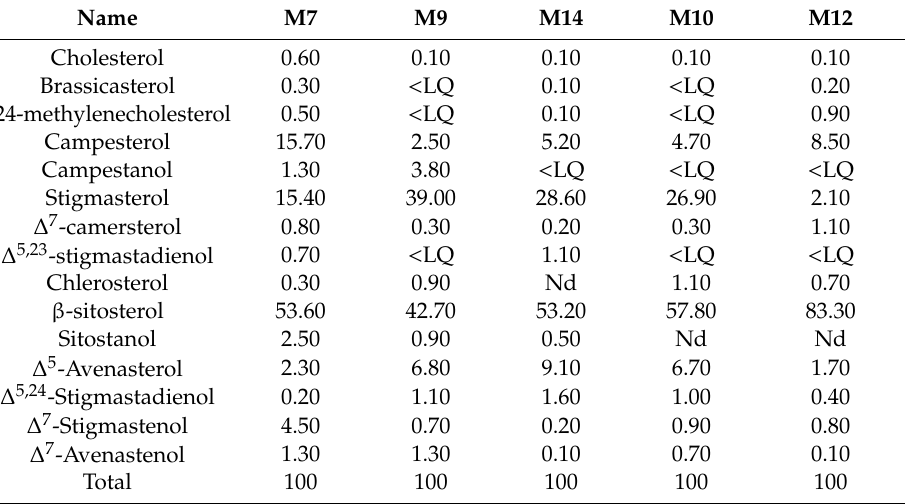
Table 3. Sterol compositions (%) of five seed